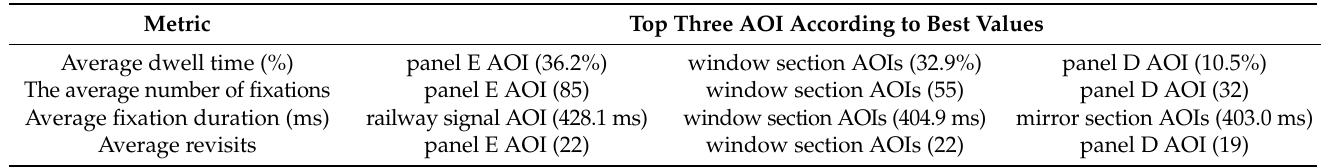
Table 7. The departure procedure’s average statistic for train station Bytˇca.